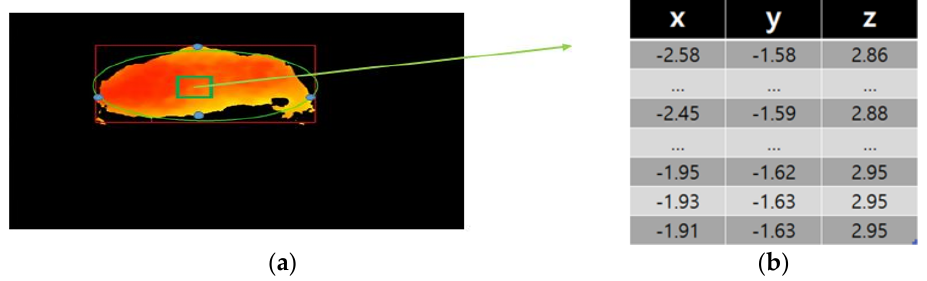
Figure 8. Show the point cloud data within a specific area: ( a ) segmented cattle image; ( b ) 3D coordinates for pixels in box region.